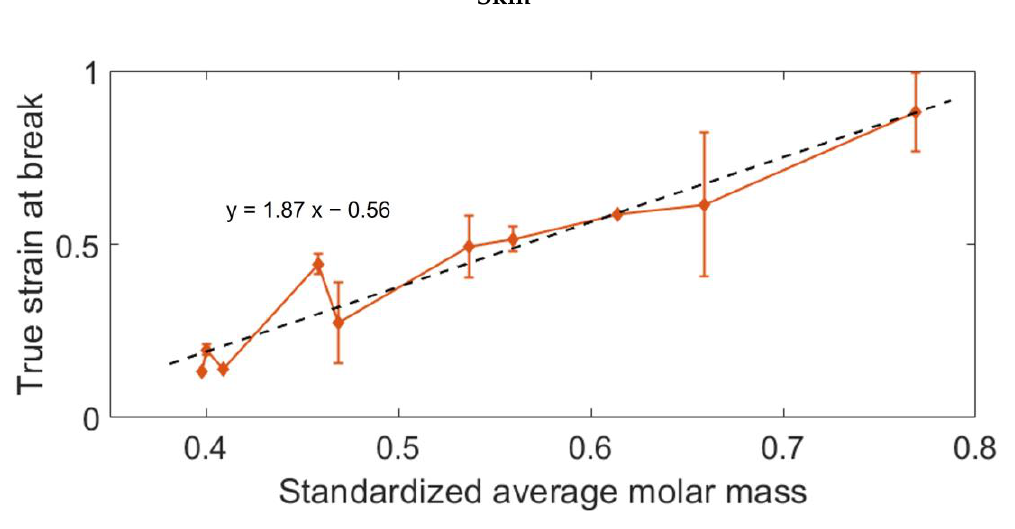
Figure 17. Evolution of the true strain at the break with the decreasing molar mass. Measurements and tendencies: ( a ) at the core; ( b ) at the skin.